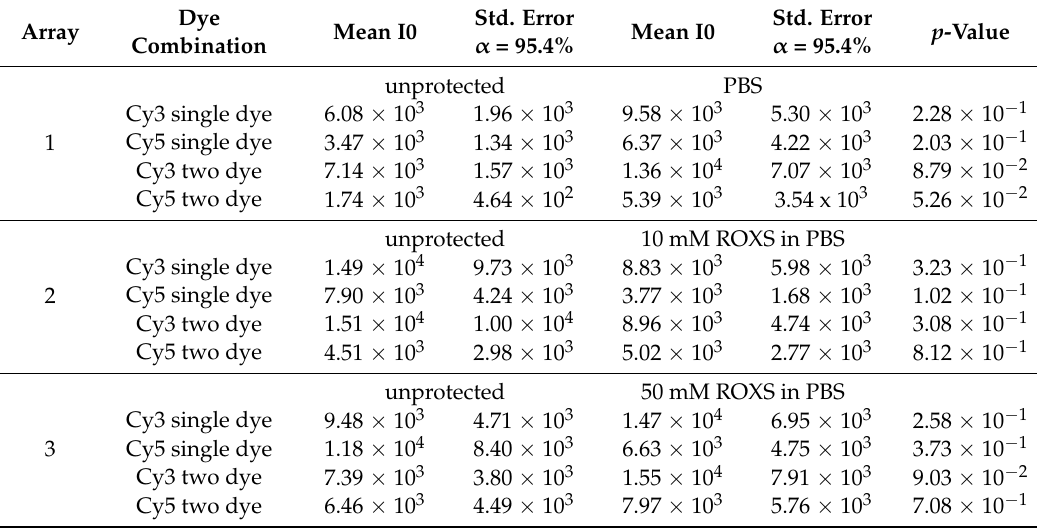
Table 1. Results and statistical metadata regarding the mean initial spot intensity (I0) of the 24 gene experiment.